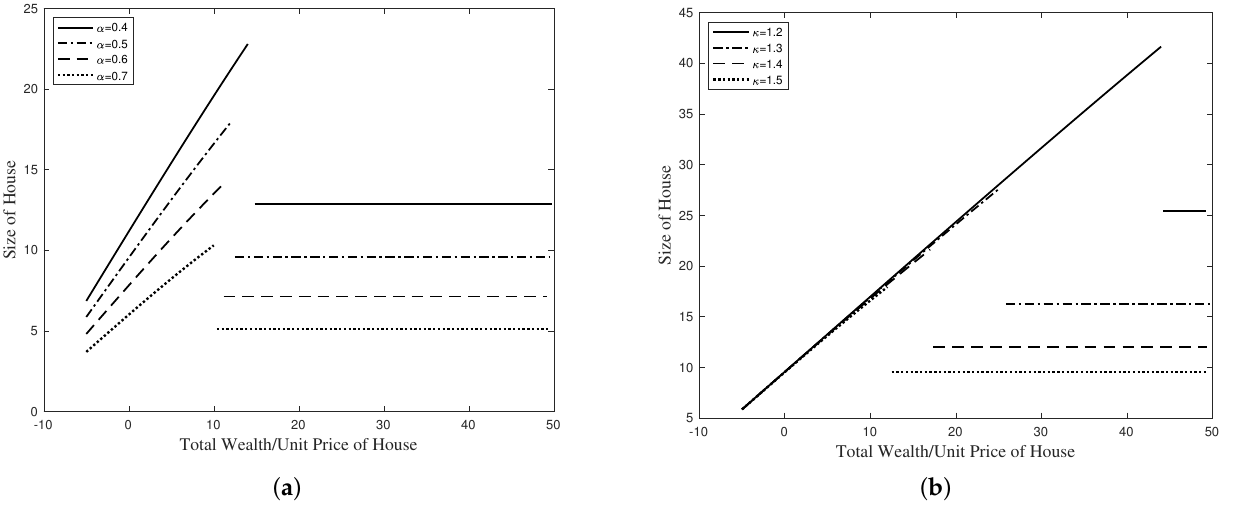
Figure 4. Optimal housing policies with changes in agent’s preference. ( a ) Elasticity of consump- tion/housing, α . ( b ) Purchasing house preference, κ